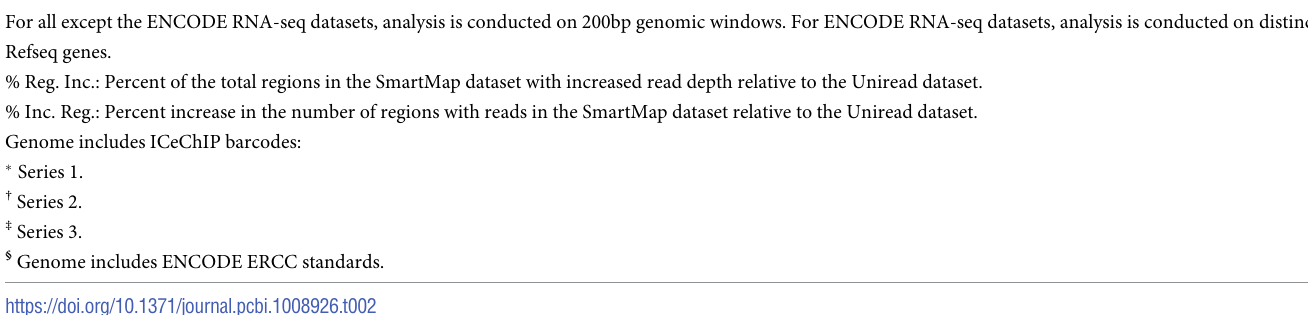
Regions with reads